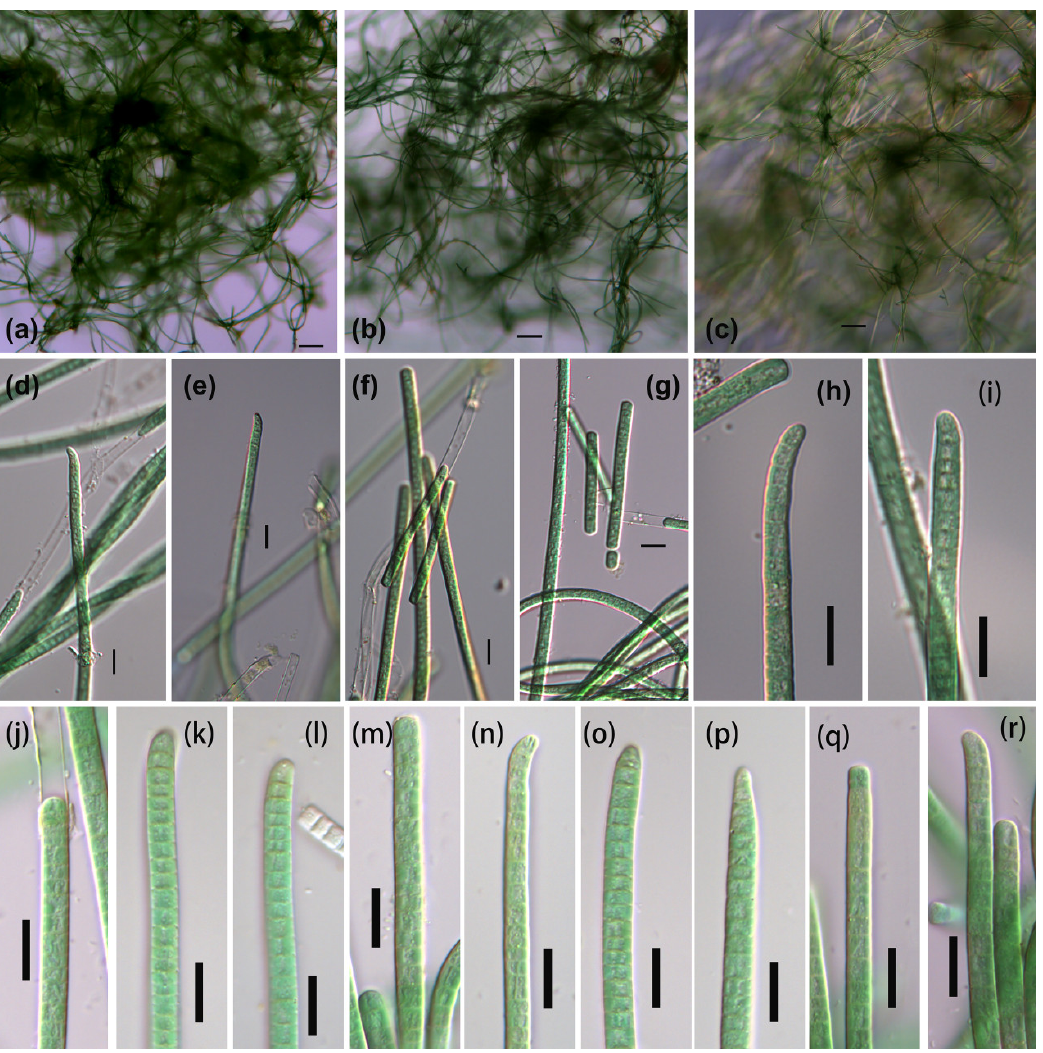
Figure 3. Light microscopy of Phormidium -like sp. 2 strains: ( a – c ) Represent twisted or entwined filaments; ( d – g ) trichomes wrapped in the sheath; ( h , i ) trichomes slightly constricted at the crosswalls; ( j – r ) the details of various diversiform of apical cells. Scale bars: ( a – c ) = 50 μm, ( d – r ) = 10 μm. Habitat: Attached on rock surfaces. Reference strains: WZU 0153, WZU 0154.